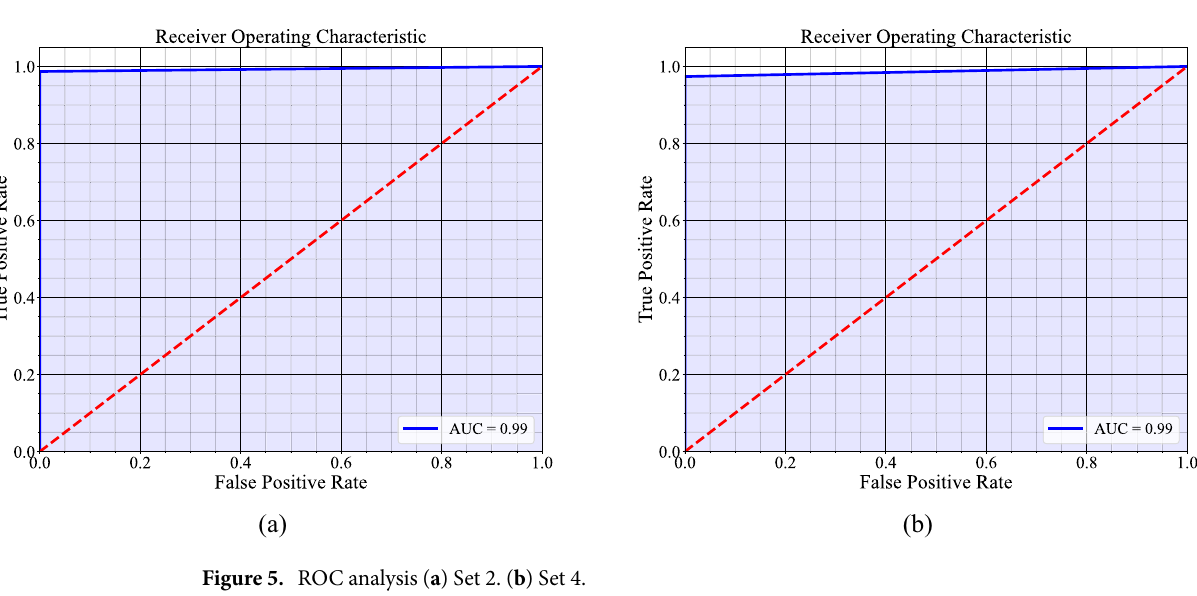
Figure 5. ROC analysis ( a ) Set 2. ( b ) Set